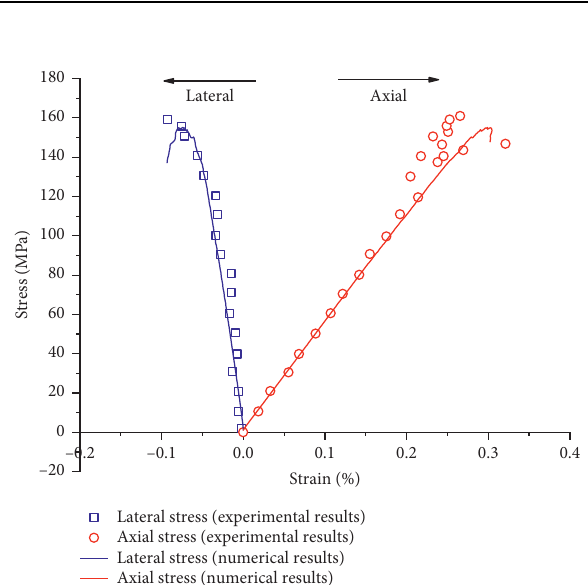
Figure 3: Comparison between numerical and experimental results of granite uniaxial compression.